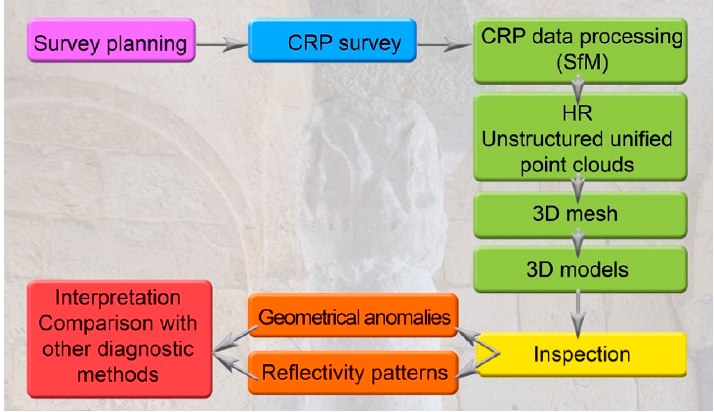
Figure 5. Flowchart of the SfM data processing.